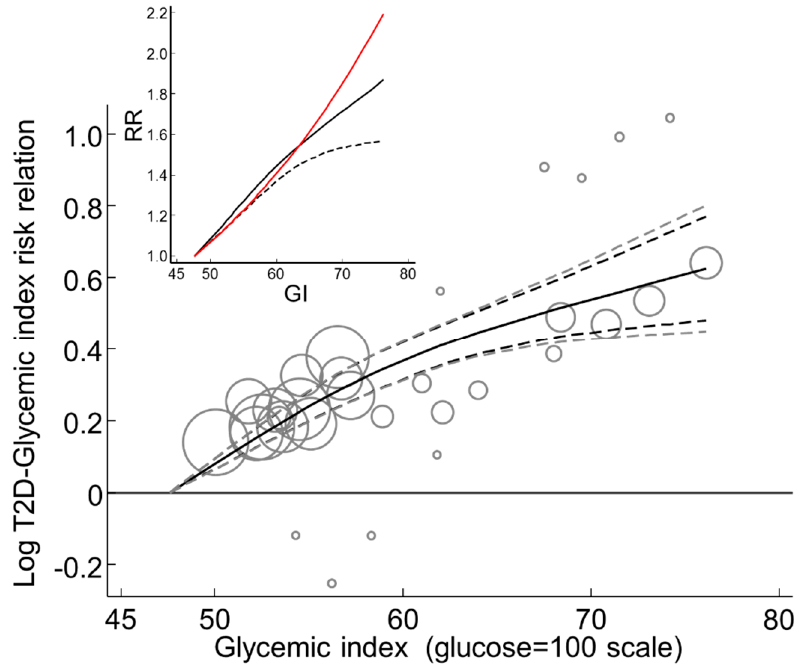
Figure 5. Global dose-response meta-analysis of the T2D–GI risk relation. The larger plot shows the mean increment in the log risk relation and 95% CI values. The 95% CI values were based on random effects analysis, the inner (black dashed) lines show the conventional CI values based on ( τ 2 + σ 2 ) whereas the outer (grey dashed) lines were based on an additional forecasting term, σ f2 , so that the outer 95% CI was based on ( τ 2 + σ 2 + σ f2 ). Insert: Shows the corresponding unlogged RR (black, continuous), the lower 95% confidence limit when accounting for σ f2 (black dashed), and the corresponding log-linear prediction (red).